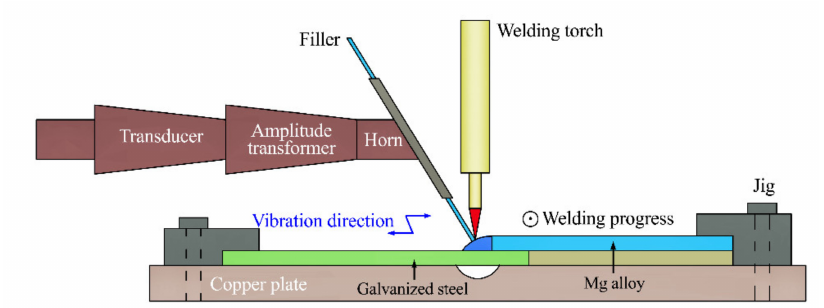
Figure 2. The sketch map of the ultrasonic vibration-assisted welding (UVAW)